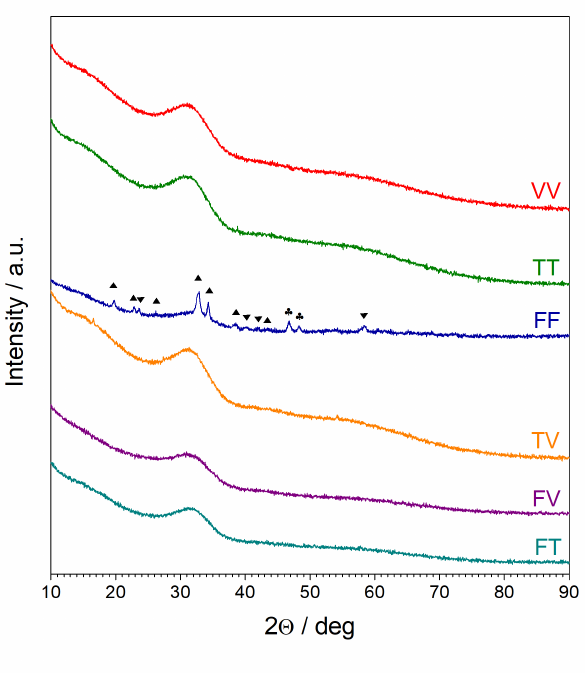
Figure 1. XRD patterns of as-synthesized NASICON-like glasses. Reflexes in FF sample were ascribed to the following phases: up-triangles—orthorhombic Na 4 (P 2 O 7 ) (ICDD 04-018-4331); down- triangles—rhombohedral Fe 2 O 3 (ICDD 01-086-8845), club—unidentified.